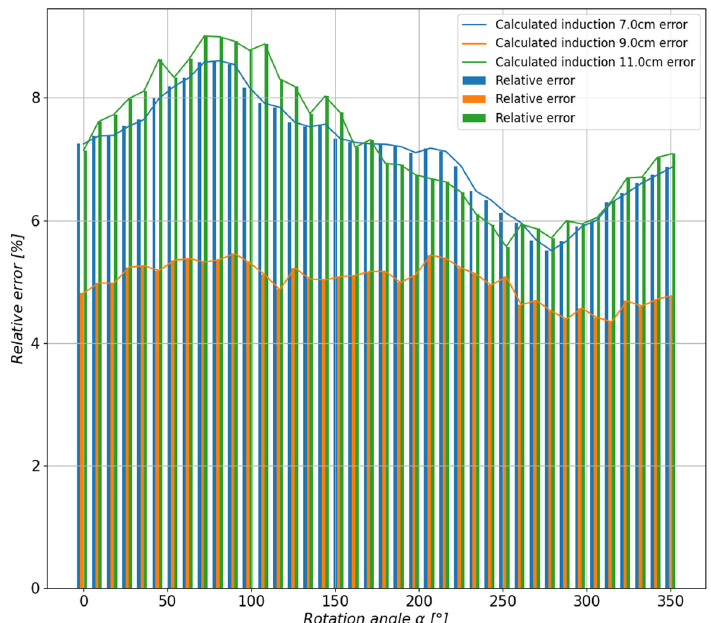
the stand rotation angle was calculated (Figure 18).